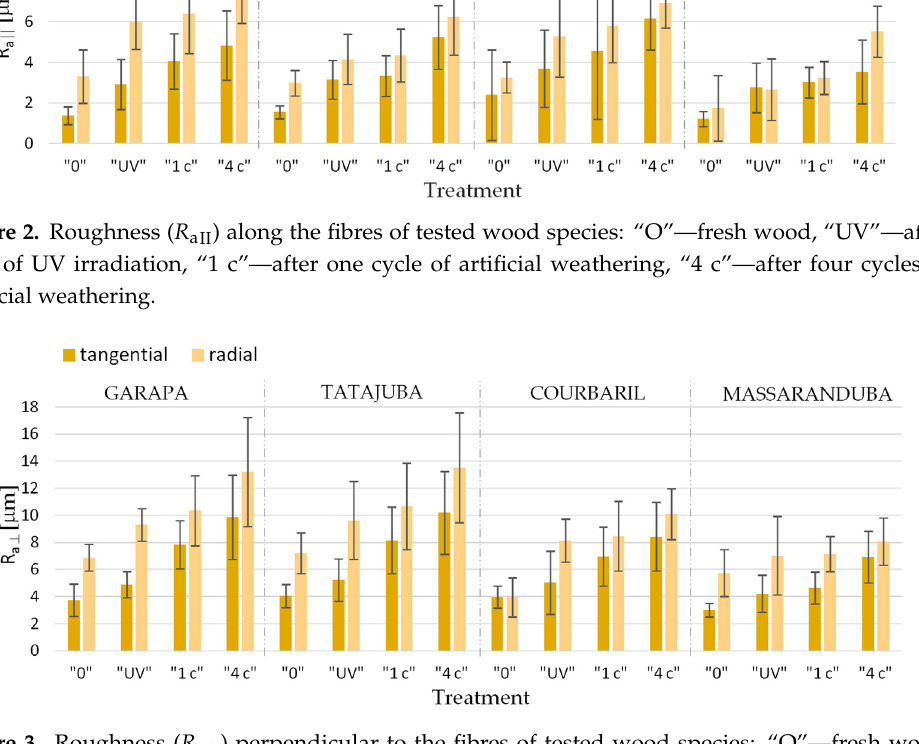
Table 4. Statistical evaluation of the factors influencing wood surface roughness.